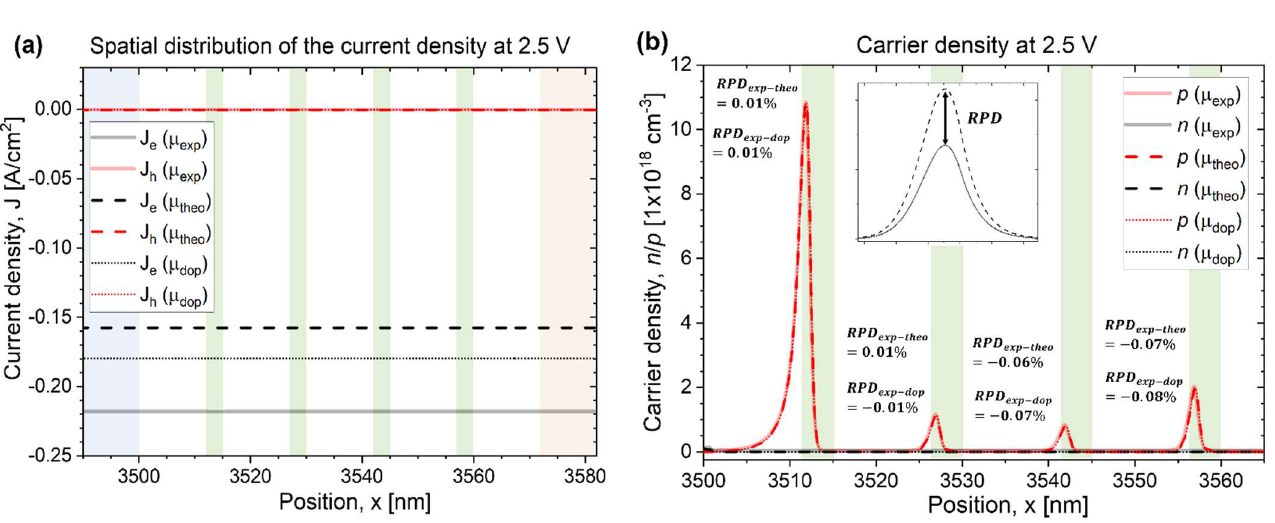
Figure 5. ( a ) Spatial distribution of current density and ( b ) carrier density in the active layer of the LED at 2.5